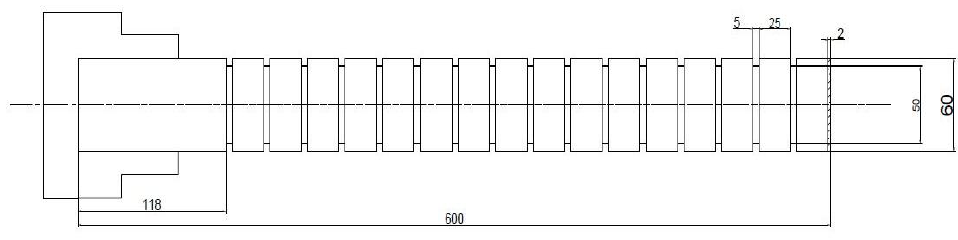
Figure 3: Sample workpiece specimen (Ahsan et